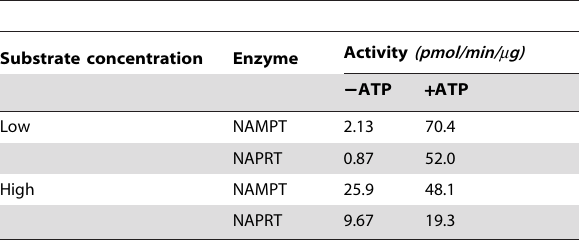
Table 2. NAMPT and NAPRT activities in the absence or presence of